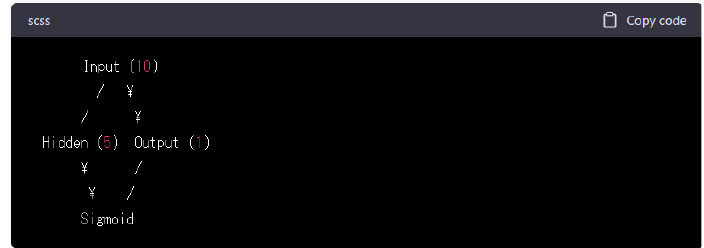
Figure 7. Example of graph representation of a deep learning model.